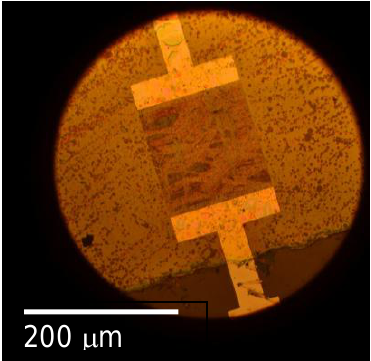
Figure 20. SAW device with SnO at 700